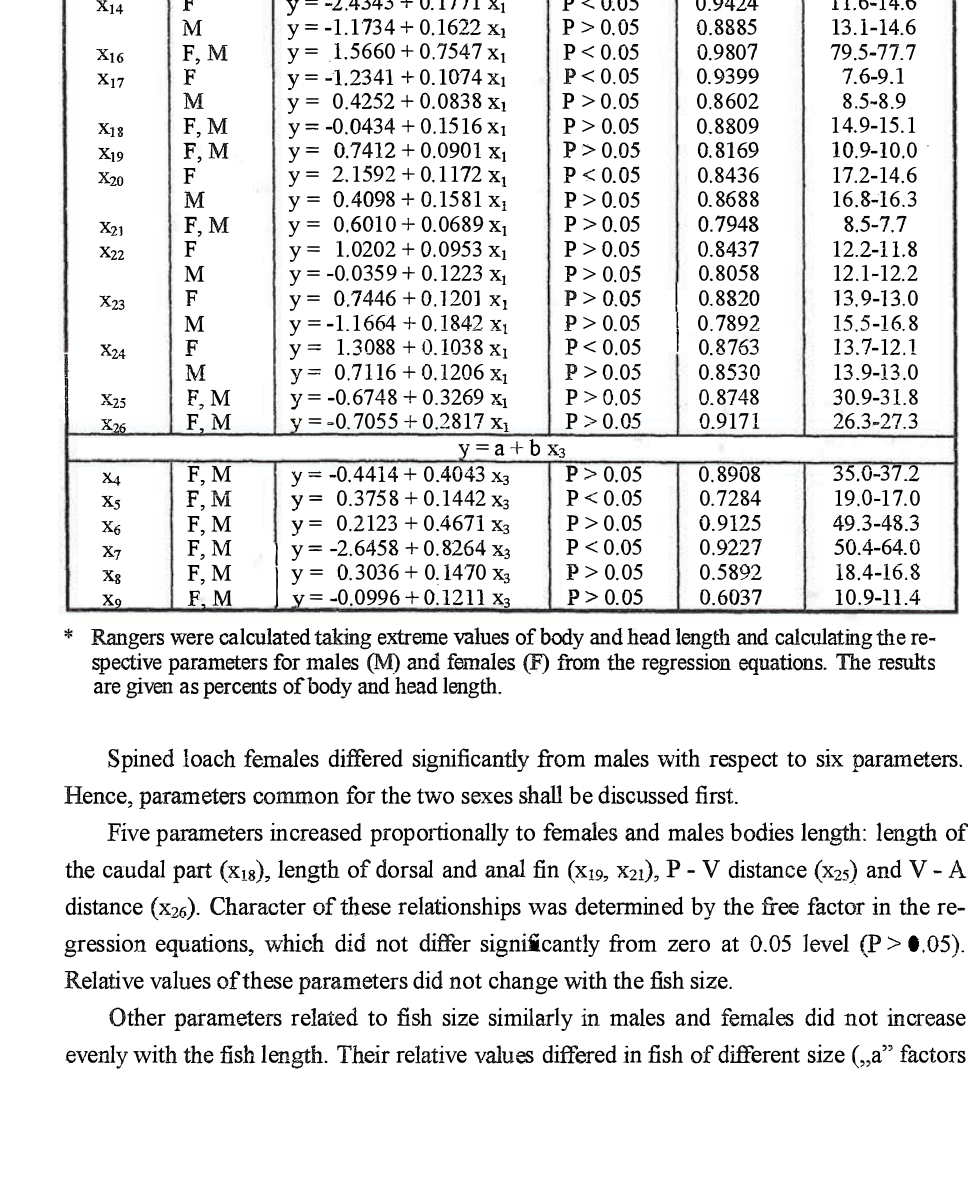
Correlation coefficients (r) and linear regression equation (y=a+bx) for the relationships between plastic body parameters (xz, X3, X1z-X26) and body length (xl), and between plastic